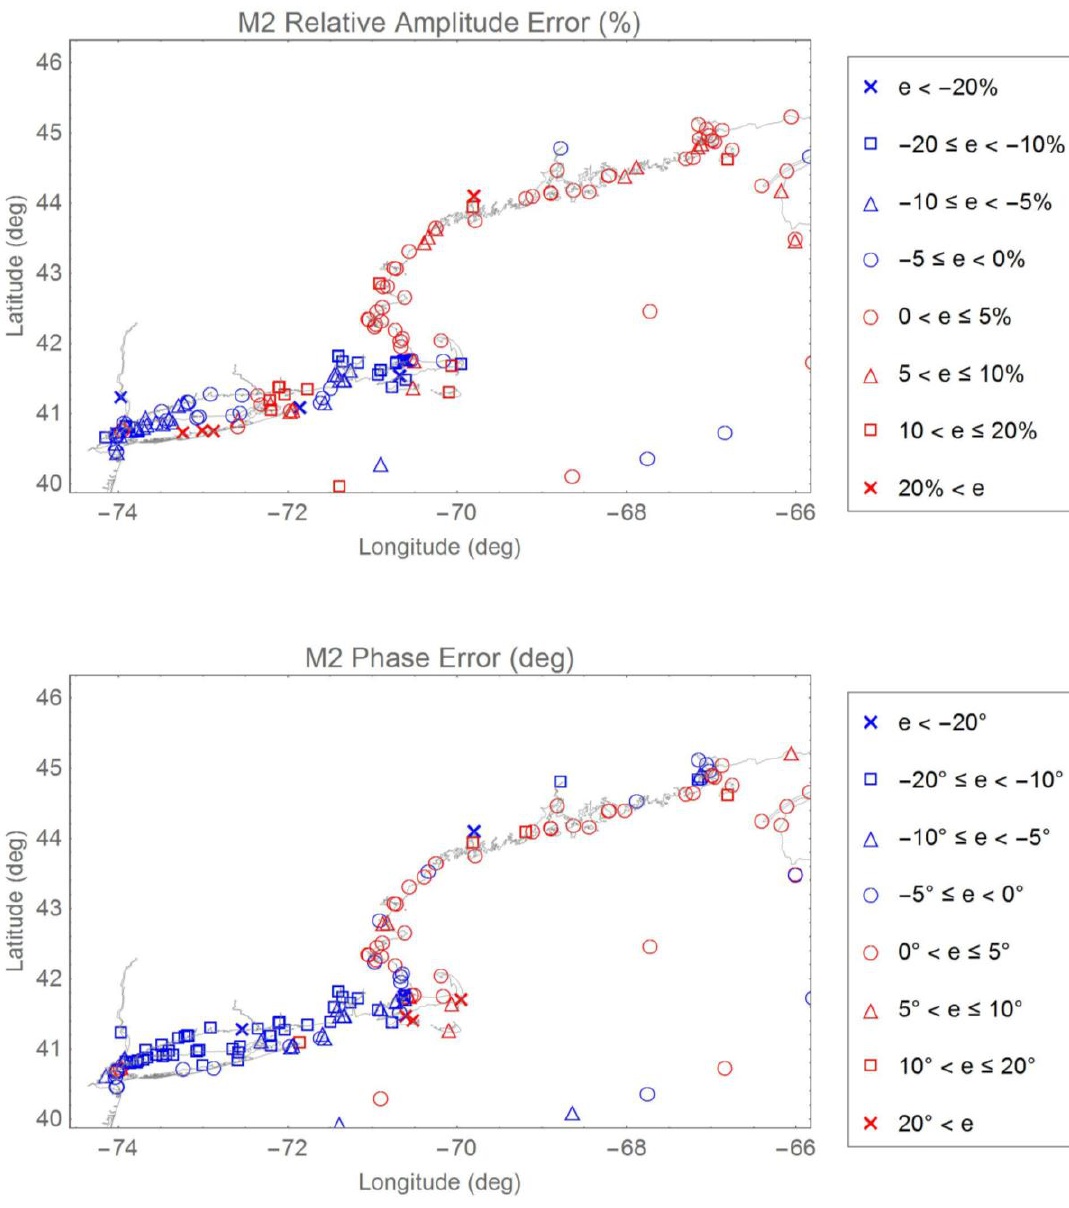
Figure C5. Distribution of relative amplitude and absolute phase errors for the M 2 constituent: Gulf of Maine and New York Bight.